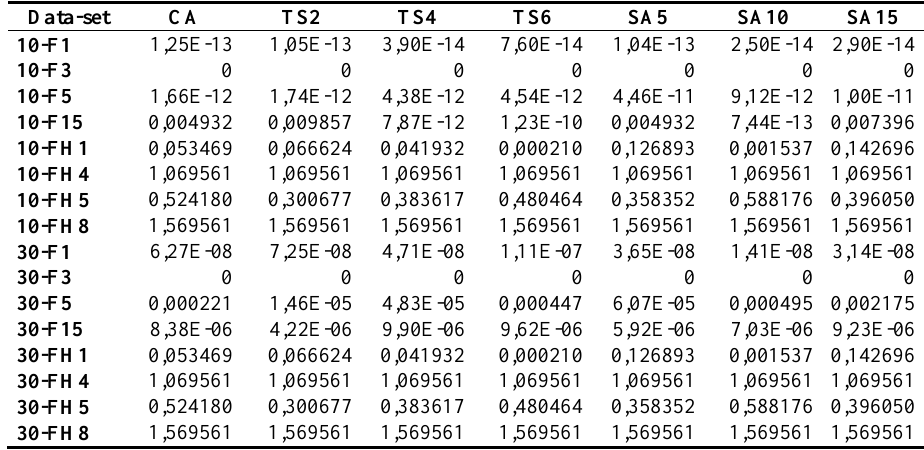
Table 5: Data entry of D-10 and D-30.